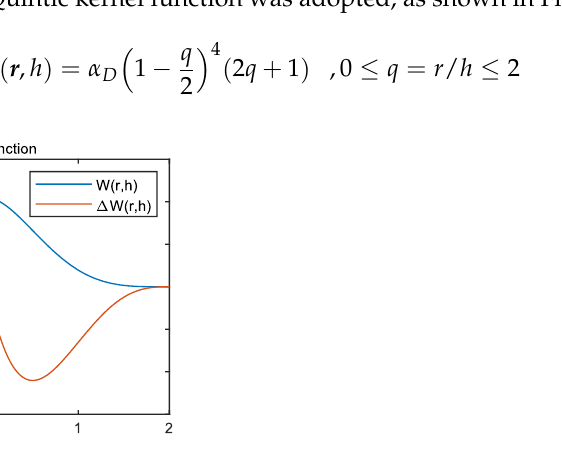
Figure 1. Kernel function and